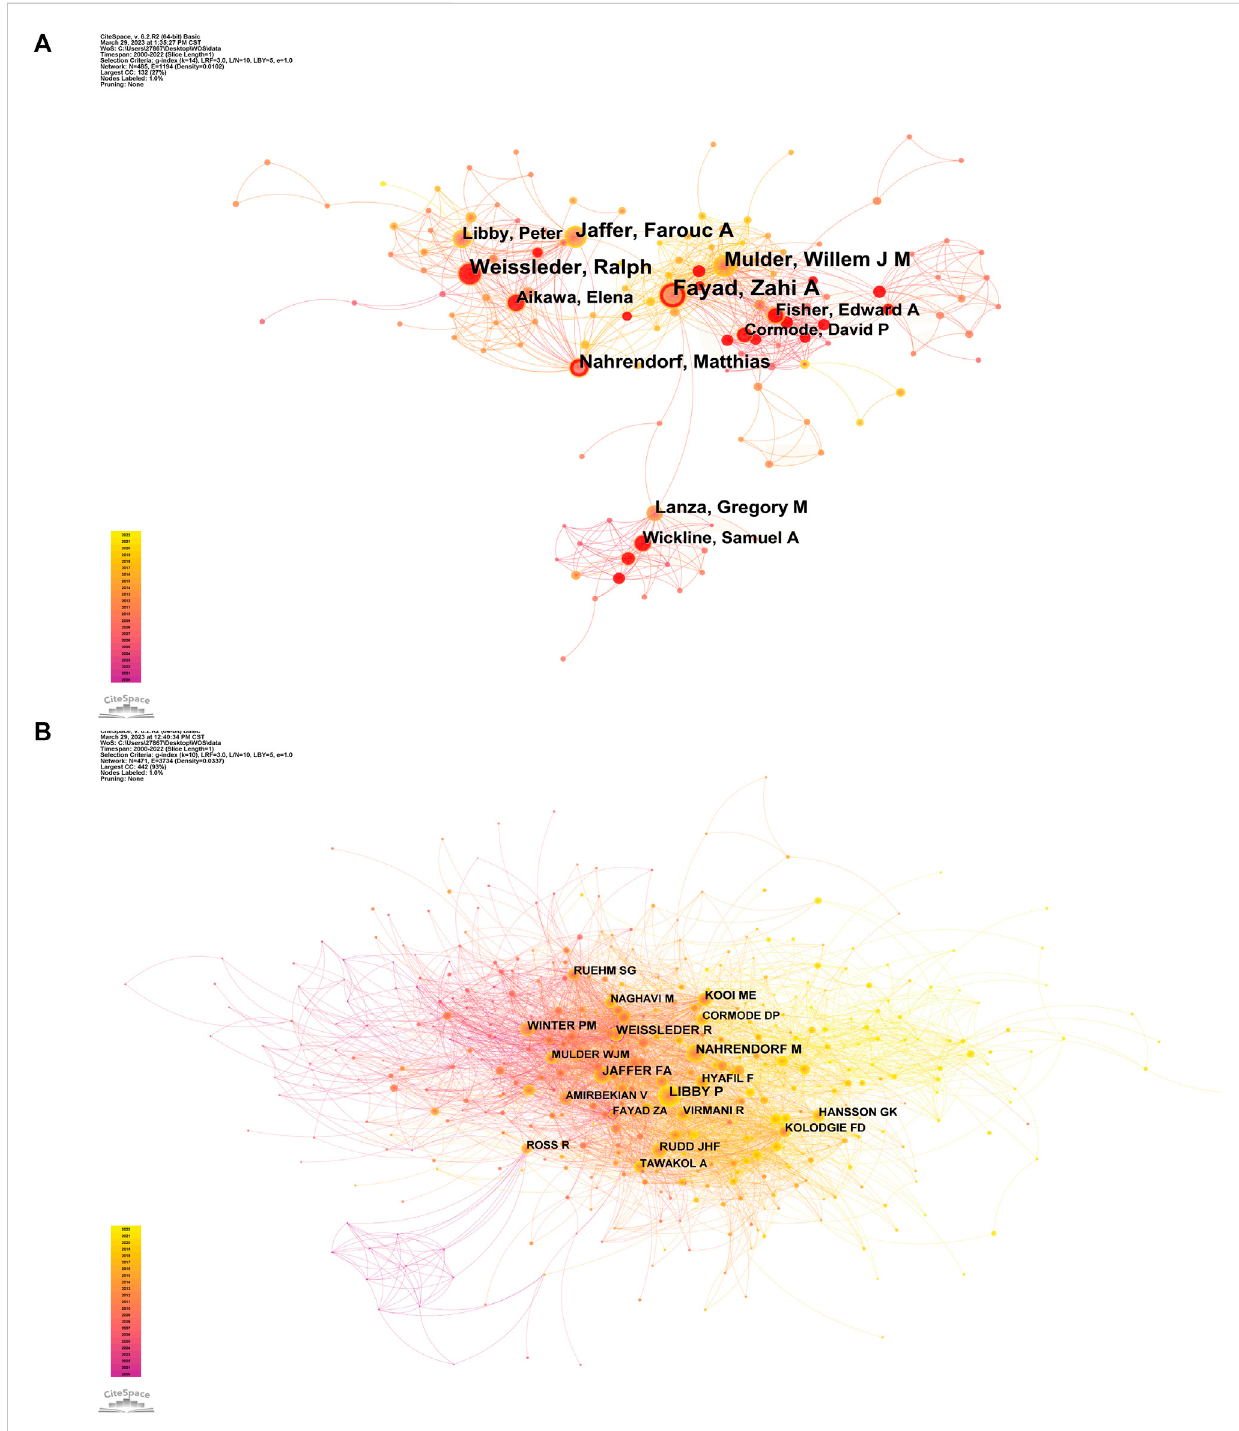
FIGURE 5 (A) The network of co-authors. (B) The network of co-cited